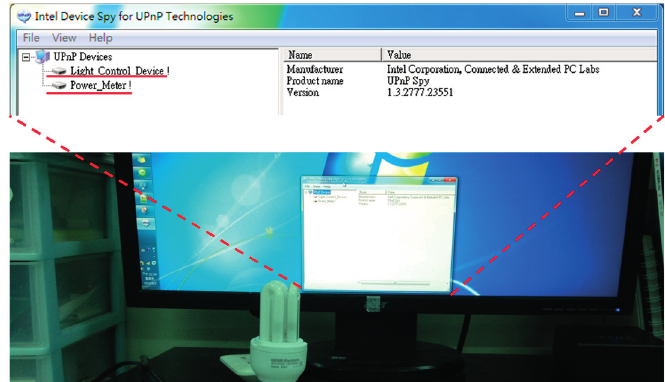
Figure 10. Using Device Spy to find UPnP devices.